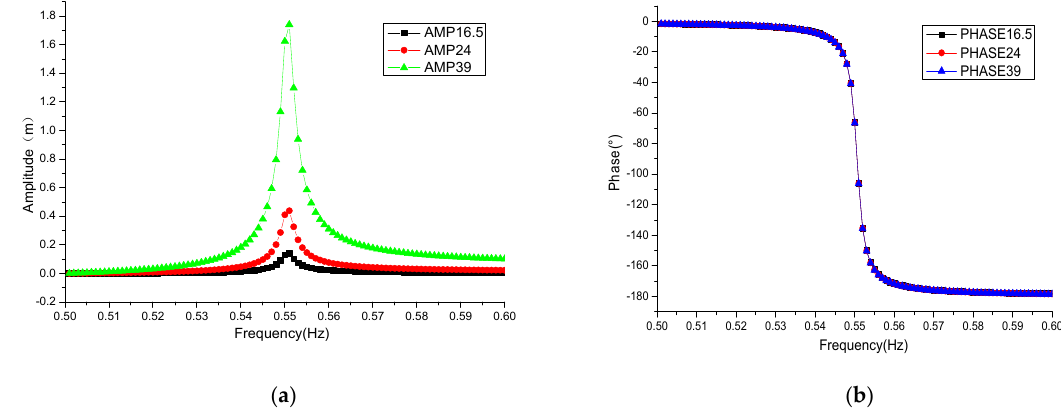
Figure 7. The resonant Bode diagram. ( a ) Amplitude-frequency diagram; ( b ) Phase-frequency diagram.